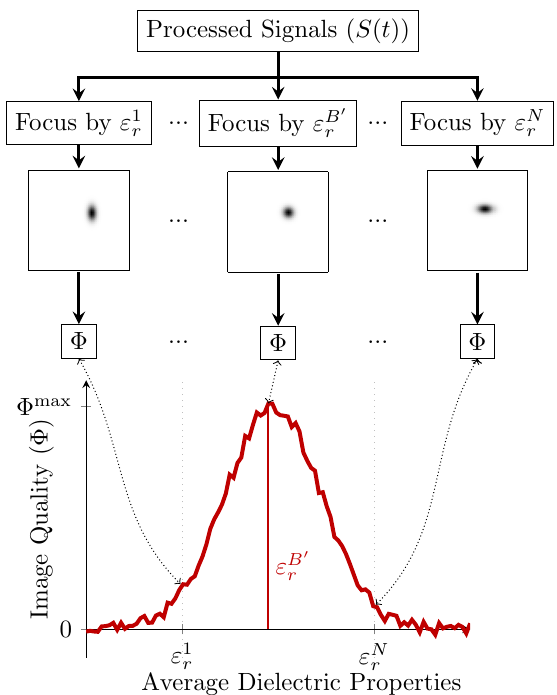
Figure 1. Block diagram of the proposed imaging system. Focal quality metrics are used in a parameter-search algorithm to identify the best-case average dielectric properties, ε B (cid:48) r . The proposed algorithm is described: from a set of images reconstructed with different average dielectric properties estimates, select the image that the measure of image quality, Φ , weights most